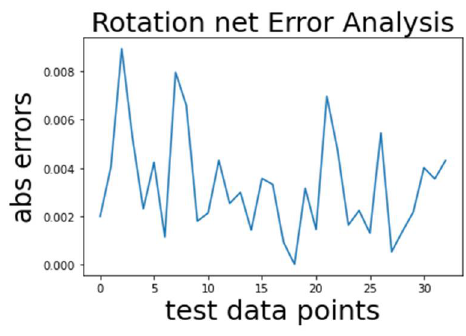
Figure 9. Projection model parameter verification with simulation data: 3D data points from a random camera model are fed to the search algorithm. Rotational error calculated using recovered model parameters.